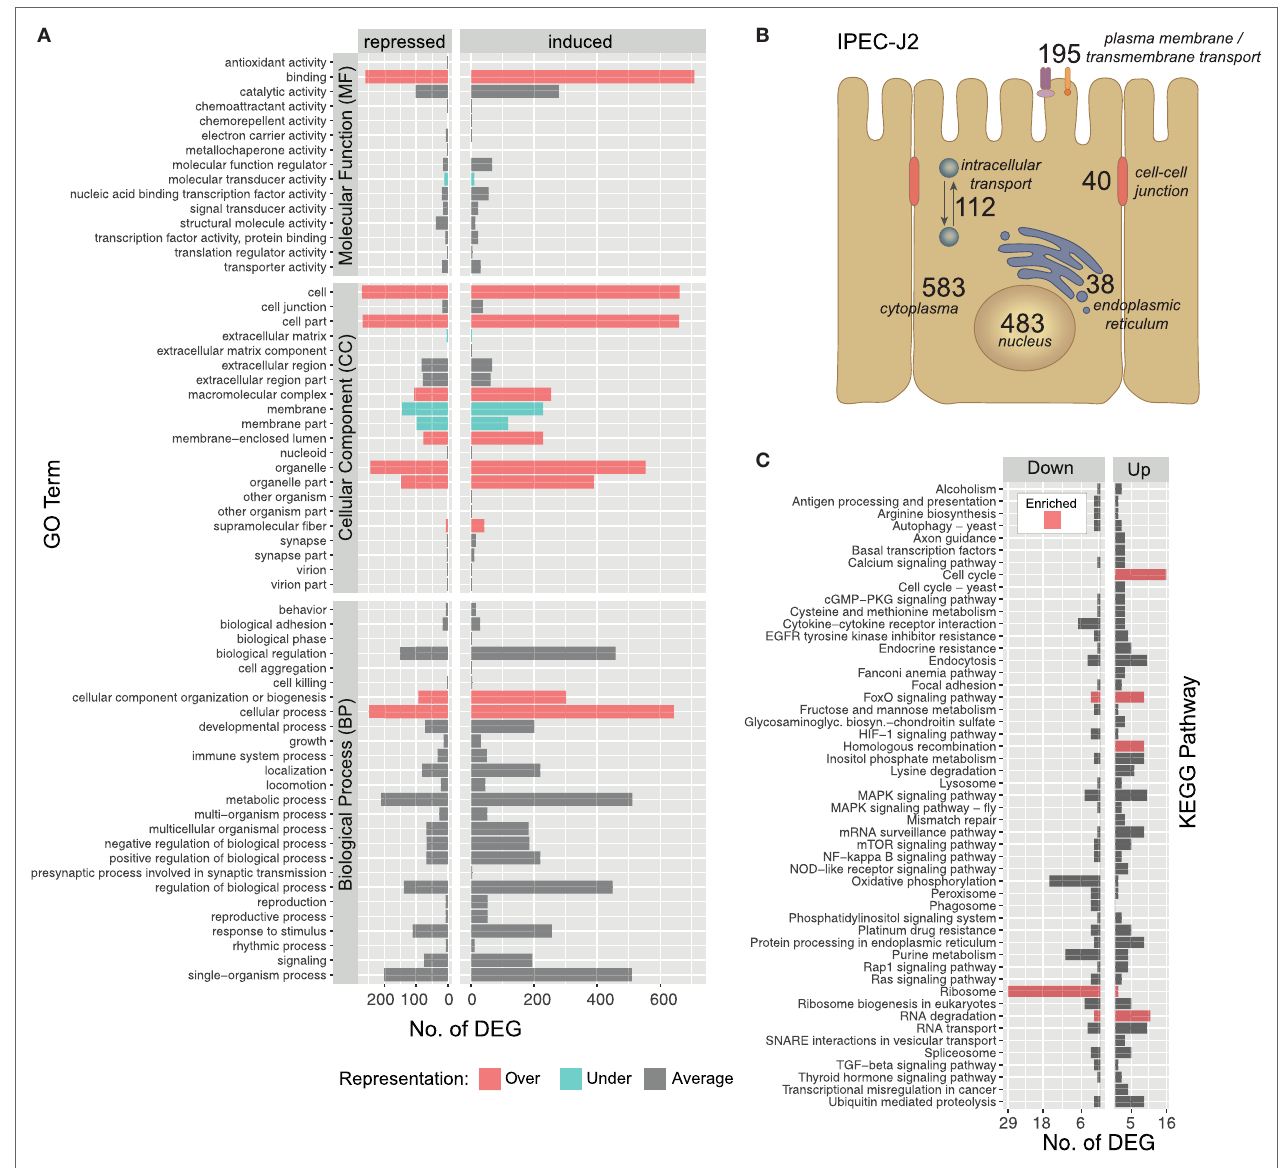
FigUre 3 | Gene ontology (GO) and pathway profiling of porcine intestinal epithelial cell differentially expressed genes (DEGs). An iterative annotation strategy was used to assign GO terms to reference and novel porcine transcripts. (a) For 1,214 GO-annotated porcine DEGs, the level 2 of GO hierarchy is illustrated and classified into Molecular Function (MF), Cellular Component (CC) and Biological Process (BP). GO terms significantly enriched among differentially expressed S. scrofa genes (Fischer’s Exact Test, two-sided, p < 0.05) are highlighted as over-( ) and under-( ) represented terms alongside with averagely represented terms ( ) with regard to the reference genome. (B) Subcellular localization of DEG encoding proteins deduced from binning relevant GO terms (Table S3 in Supplementary Material) and offsprings [ nucleus (CC, 483), endoplasmic reticulum (CC, 38), cytoplasm (CC, 583 ), intracellular transport (BP, 112), plasma membrane (CC, 128), transmembrane transport (BP, 34), transmembrane transporter activity (MF, 33), cell–cell-junction (CC, 31), and cell–cell junction organization (BP, 9)]. (c) Sequences were annotated with KEGG pathways and pathways with three or more assigned DEGs are visualized including color-coded ( ) enrichment analysis (hypergeometric test, p <